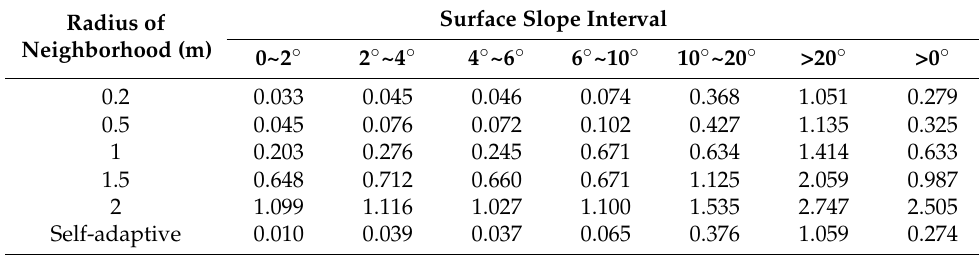
Figure 15. Accuracy of surface aspect estimation with different grades of slope and neighborhood point selection radii. Table 6. Root mean square error of wave surface aspect estimation in different intervals.